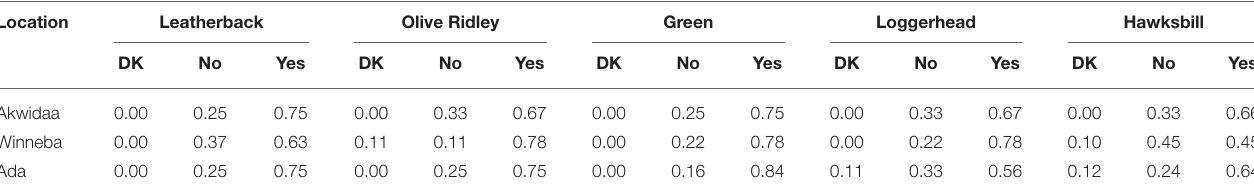
Taboo The fishers were able to identify sea turtles, but they roughly classify leatherbacks as a “large turtle” and all other species as “small turtles”. When shown photographs of each species, fishers could identify different species they have encountered. Most fishers reported catching leatherbacks, olive ridleys, and green turtles, with incidence rates of 75–80% across sites ( Table 3 ). Over 50% indicated they have captured loggerheads and hawksbills, although these two species do not routinely